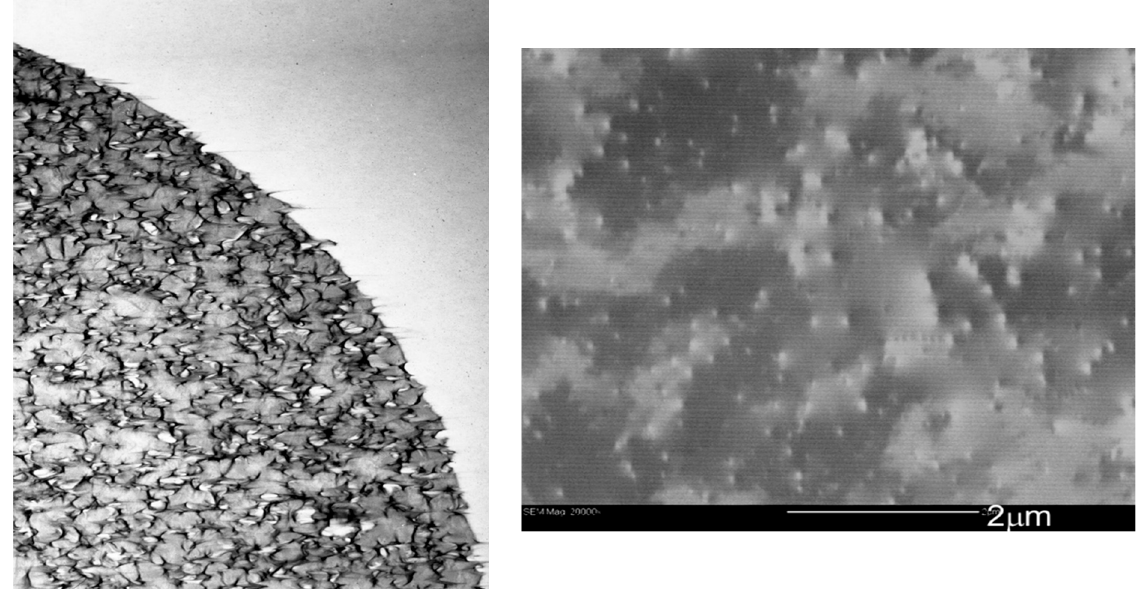
Figure 8. X-ray topography of GaN/GaN showing a nearly uniform distribution of strain centers. The grazing incidence topography is similar to the transmission image; the grazing image also shows the nearly uniform distribution of strain centers. The X ray image shows that individual threading dislocations are not resolved showing a relatively low dislocation density in those regions. The cathodoluminescence (CL) image on the right shows a defect density of greater than 10 4 cm − 2 [61].